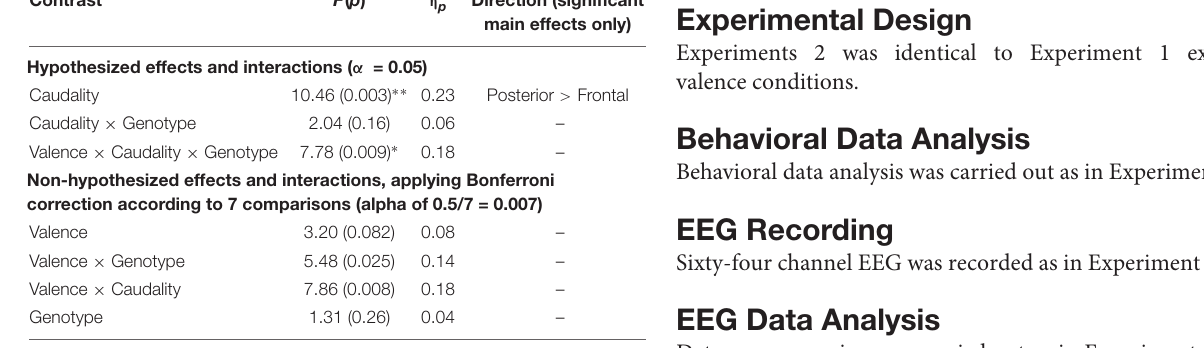
TABLE 3 | Experiment 1: Results of mixed factorial ANOVA of old-new difference scores with factors of Valence (2) × Caudality (2) × Group (2). Contrast F ( p ) η 2 p Direction (significant main effects only) Hypothesized effects and interactions ( α = 0.05) Caudality 10.46 (0.003) ∗∗ 0.23 Posterior >